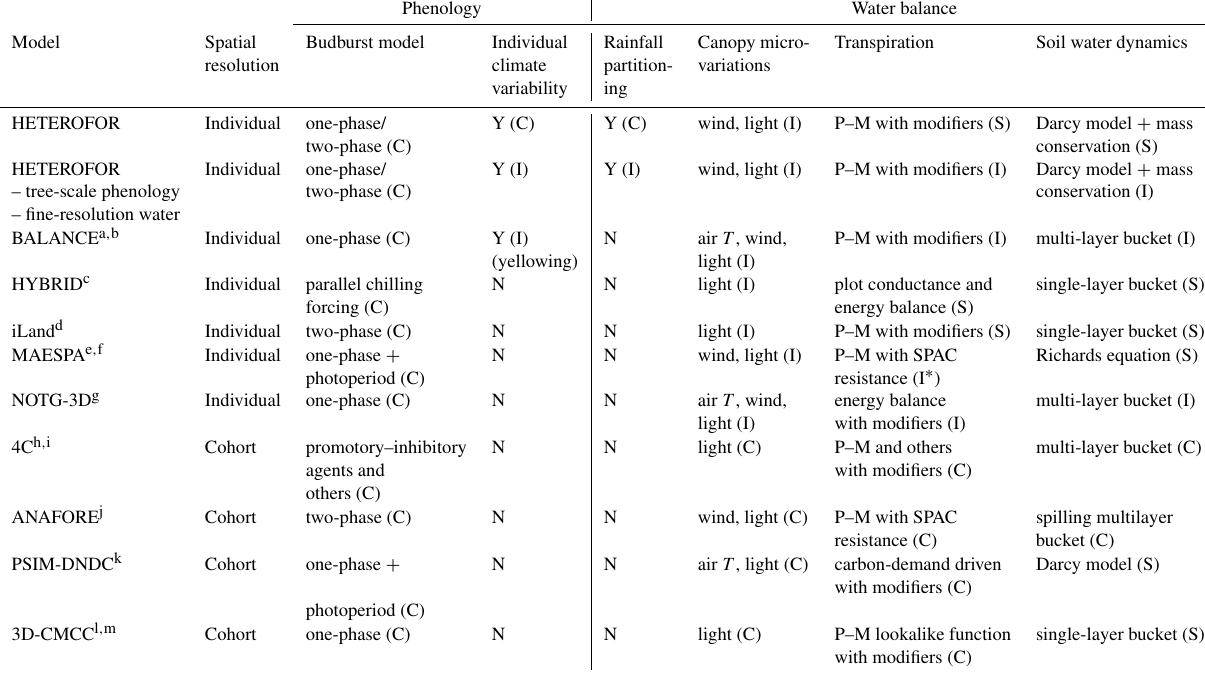
Table 5. Comparison of the spatial scale (S: stand; C: cohort; I: individual; and I ∗ : individual target tree) and concepts used for describing phenological and hydrological processes in HETEROFOR and in other individual and cohort-based models. Backslash is used to distin- guish the various model options. Abbreviations used in for describing transpiration (P–M: Penman–Monteith; SPAC: soil–plant–atmosphere